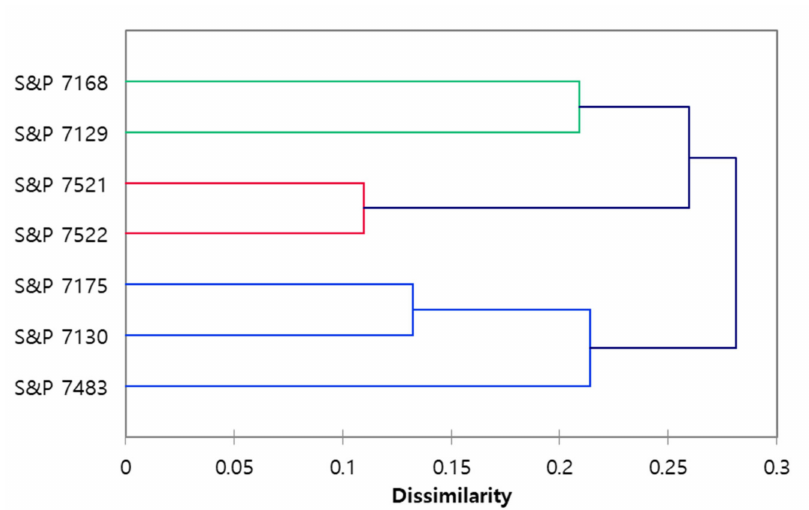
Figure 1. Phylogenetic tree of the resistant and susceptible lines provided by ‘Seeds & People’ Co. by a RAPD analysis. The resistant lines S&P 7168 and S&P 7129 showed a close genetic relationship, and also, resistant lines S&P 7522 and S&P 7521 showed a close genetic relationship. The susceptible onion lines S&P 7175, S&P 7130, and S&P 7483 appeared to have a closer genetic relationship.